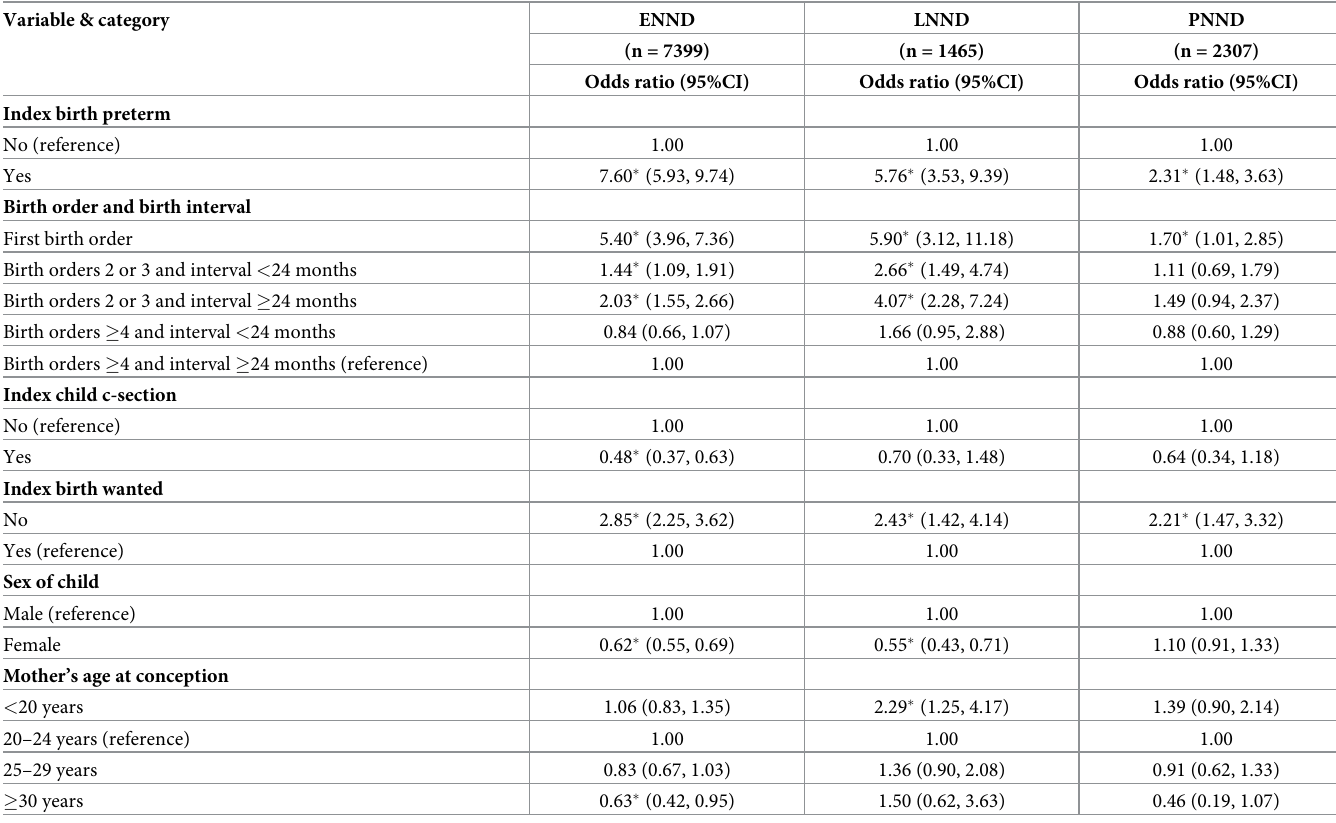
Table 2. Mother fixed-effects multivariable logistic regression results for ENND, LNND, and PNND for all births in last five years, NFHS-4, India, 2015–16. Variable &